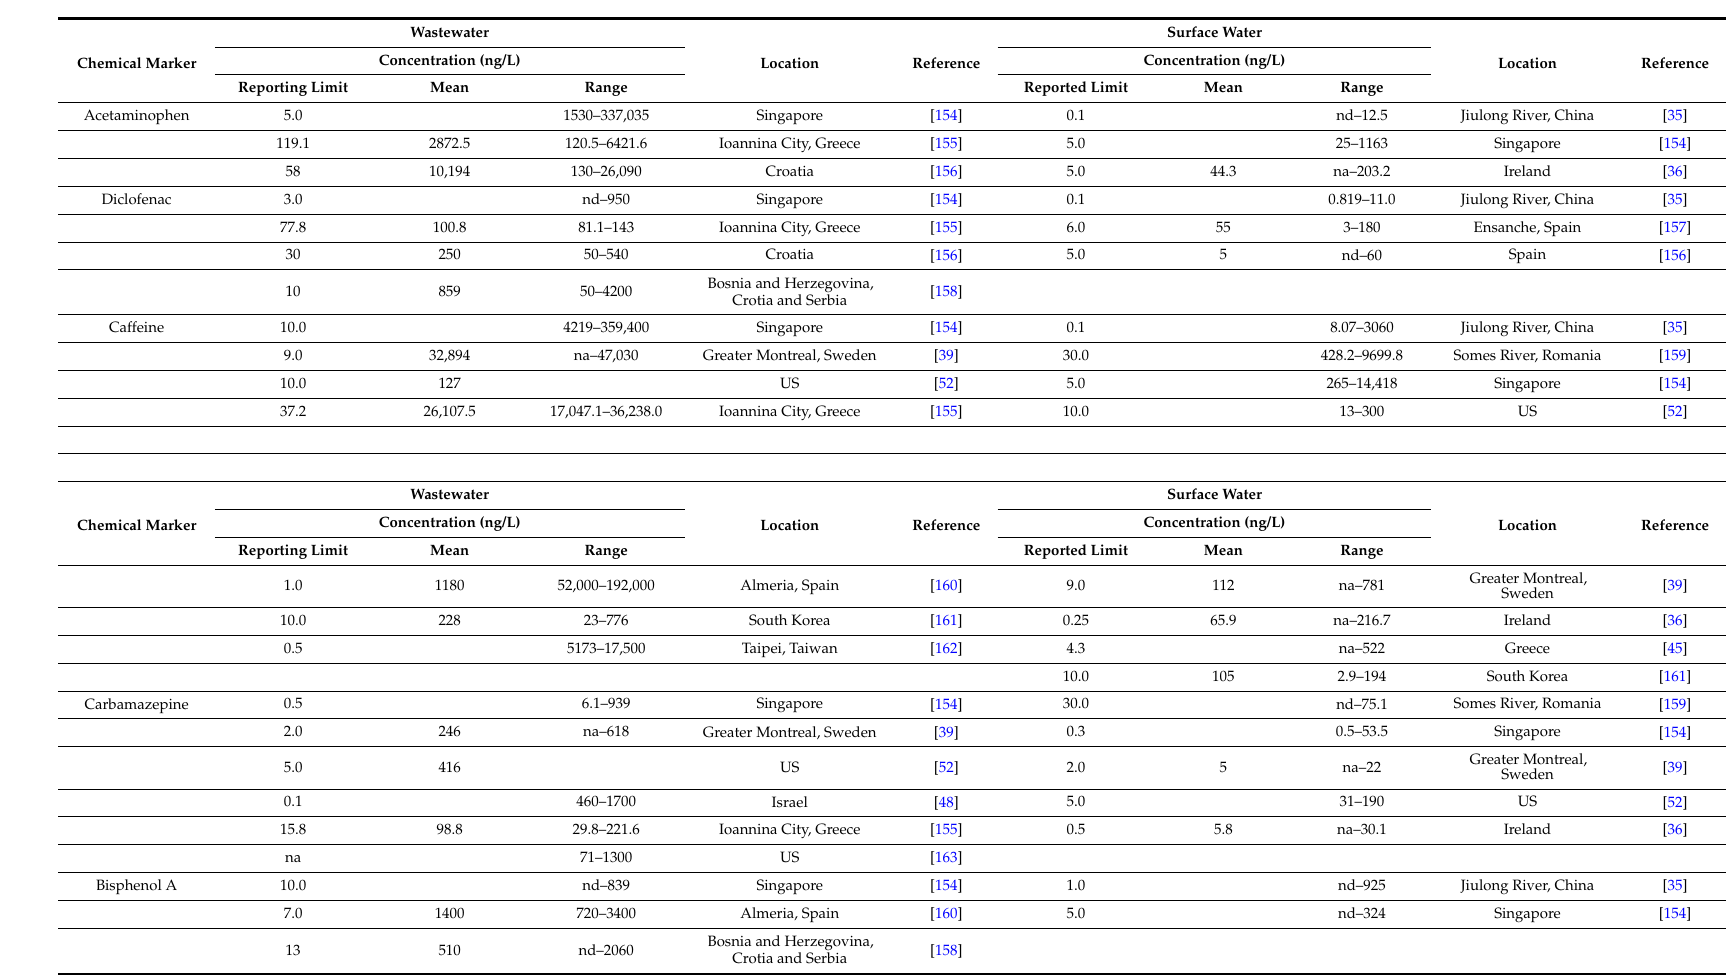
Table 4. Concentrations of chemical markers detected in wastewater and surface